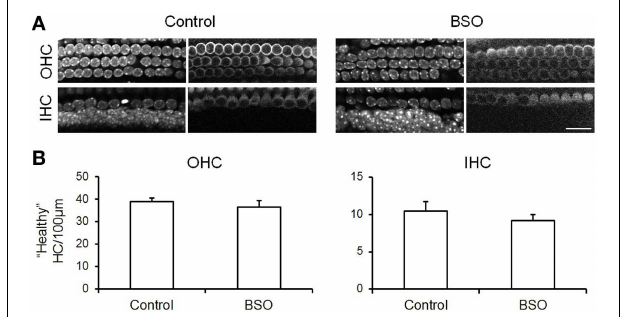
FIGURE 4 | Depletion of cellular GSH using BSO does not cause hair cell death. (A) Confocal images of the OHC and IHC regions in control and BSO-treated cochlear cultures immunolabeled with MyoVIIA (right panels) and stained with DAPI (left panels). (B) Quantification of “healthy” hair cells in control and BSO-treated samples per 100 µ m length of the cochlea. Cells were considered to be healthy if they exhibited normal chromatin and were positive for MyoVIIA. Data are presented as mean ± SEM. N for control (8) and BSO-treated (9). Student’s t -test, revealed no statistical differences. Scale bar: 20 µ